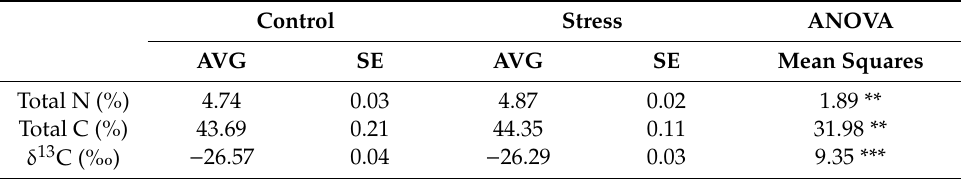
Table 2. Average (AVG) and standard error (SE) for the stable isotope composition of carbon ( δ 13 C) and total carbon (Total C) and nitrogen (Total N) concentrations of the dry matter of aerial biomass sampled before (control) and after (stress) drought was imposed on the 248 EDP accessions. The outputs of the ANOVA for treatment e ff ect (water availability) are included to the right of the variable. Level of significance ** p < 0.01, *** p < 0.001. Control Stress ANOVA AVG SE AVG SE Mean Squares Total N